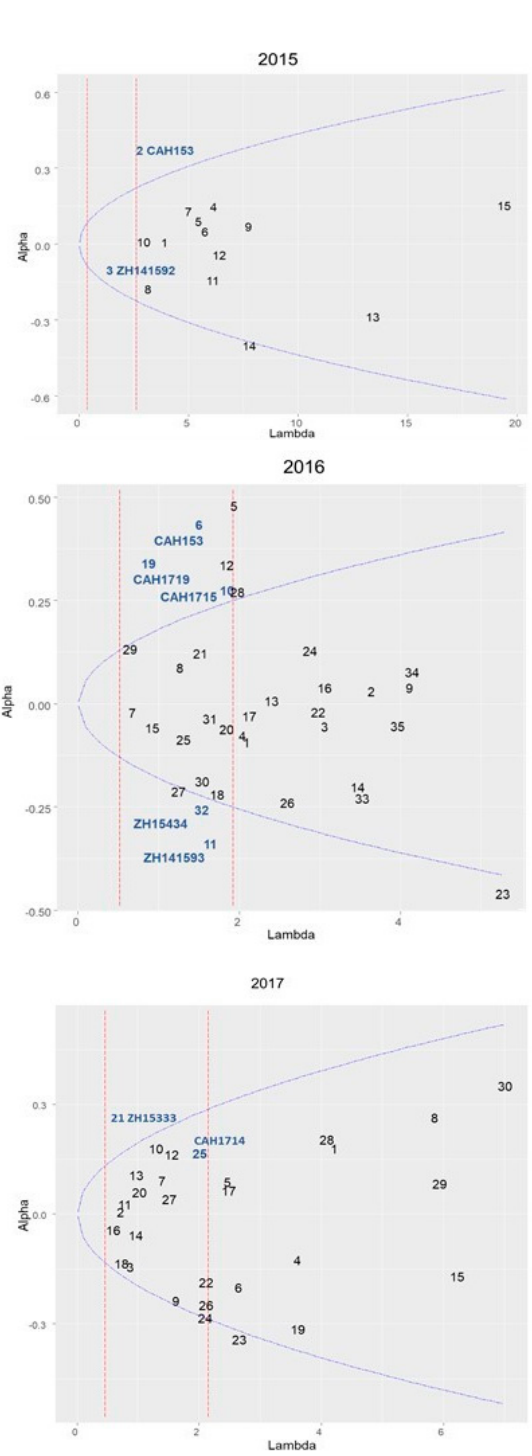
Figure 4. Tai stability plot with stable genotypes across different heat stress environments from 2015 to 2017.